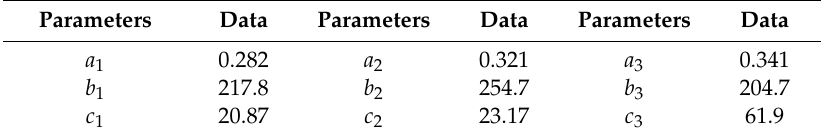
Table 2. Simulated enhanced vegetation index (EVI) function parameters of summer maize in reference area.